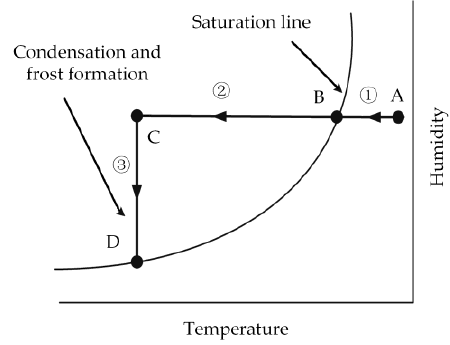
Figure 4. The process of nucleation of water vapor around a cold surface [64].